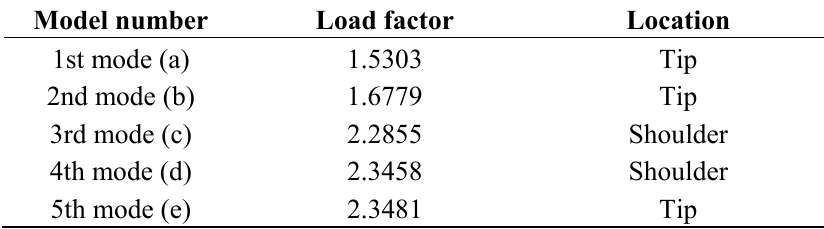
Table 4. Mode vs. load